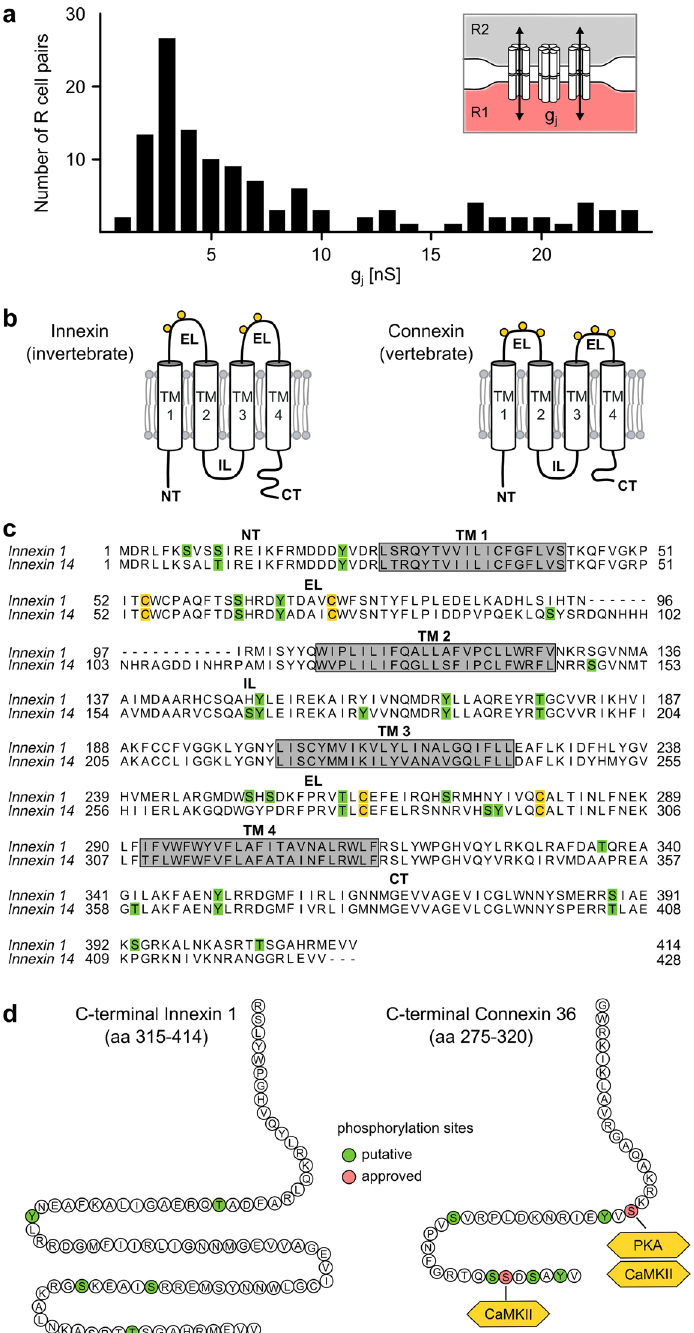
Figure 2. The structure and variable strength of Innexin-1 electrical synapses indicate their potential for plasticity. ( a ) The gap junctional conductances (g j ) of electrically coupled R cells (see inset) show a wide distribution (n = 123 R cell pairs from 78 different animals) that differed significantly from a normal distribution (p < 0.001, Shapiro-Wilk). ( b ) Innexins and connexins share a common membrane topology with four transmembrane (TM), one intracellular (IL) and two extracellular (EL) domains 15 each containing conserved cysteine residues (yellow circles) that are critical for stable gap junction channel formation 72 . Based on the sequence alignment and analysis in ( c ), we predicted the structure of Innexin-1 in comparison to the neuronal gap junction protein Connexin-36 of vertebrates. ( c ) Amino acid alignment of the two innexins that are predominantly expressed 38 in our experimental system, the leech R cells. NetPhos 2.0 70 was used to predict putative phosphorylation sites (green) and TMHMM 2.0 71 was used to predict transmembrane domains (TM, grey boxes) of Innexin-1 and Innexin-14, respectively. Alignments were performed using Clustal W software. ( d ) Putative phosphorylation sites in the Innexin-1 carboxyl tail compared to the approved and putative phosphorylation sites in Connexin-36 42,45